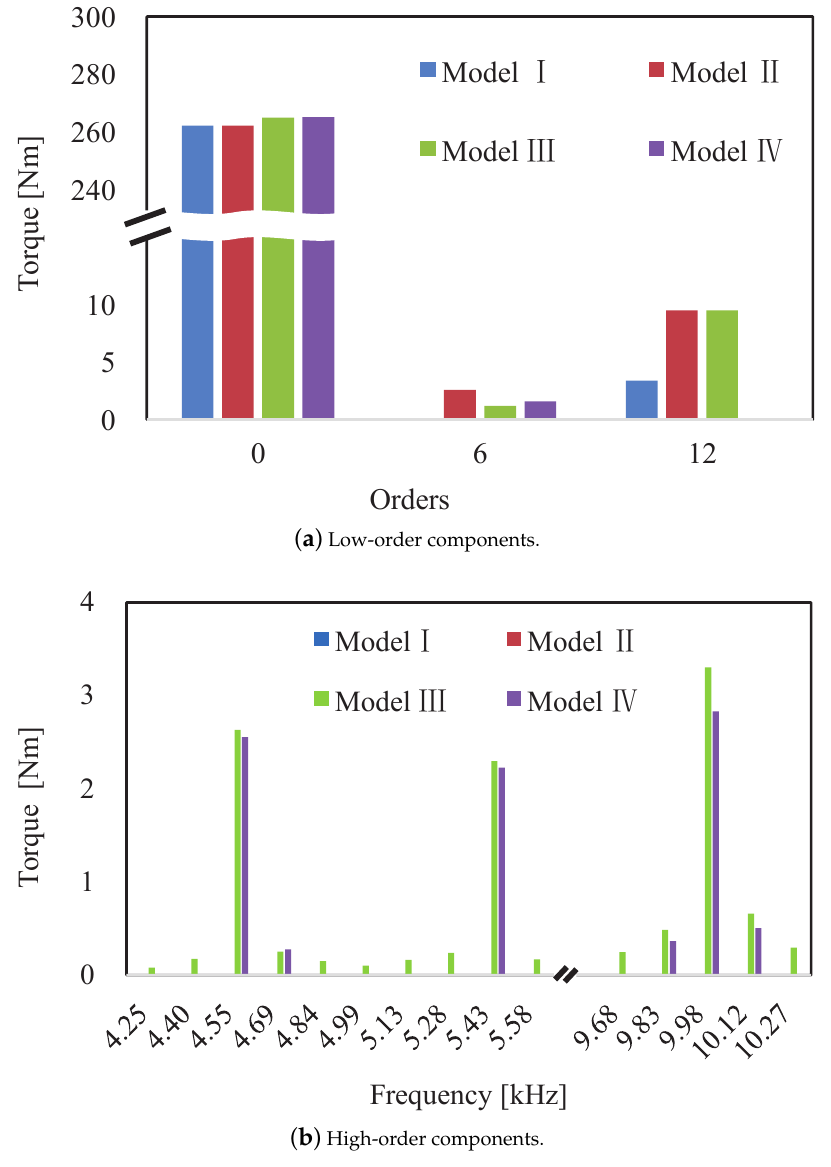
Figure 11. Comparison of torque harmonics in different models. ( a ) Low-order components. ( b ) High-order